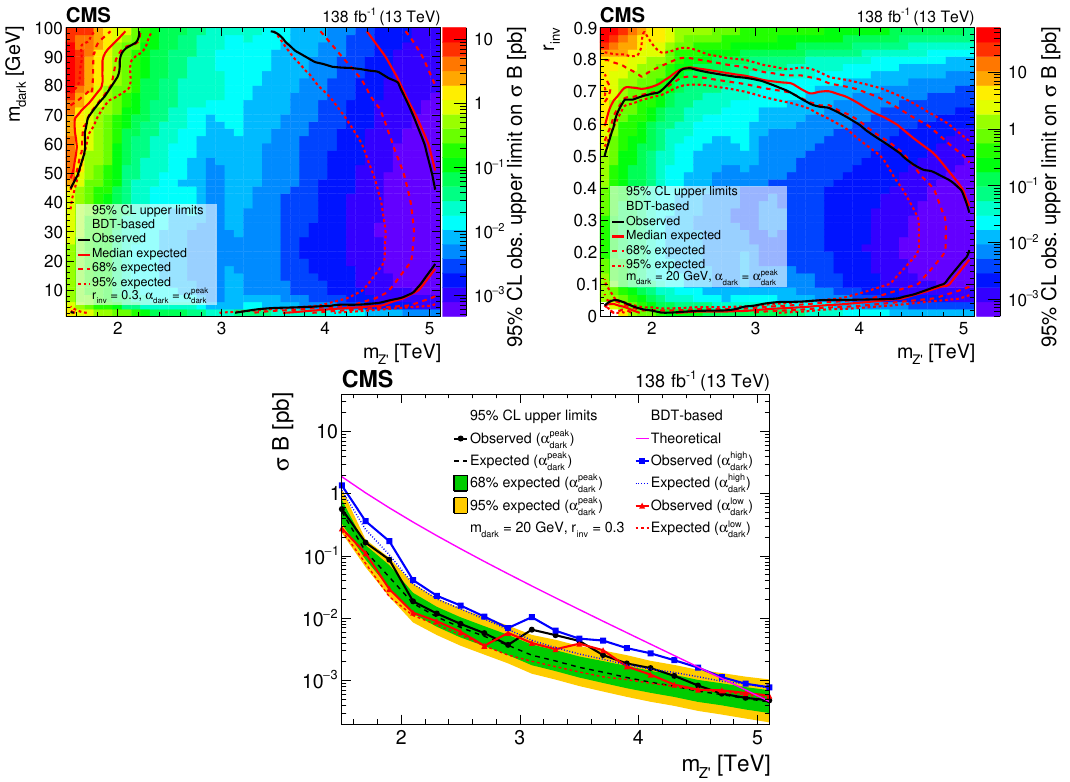
Figure 8 . The 95% CL upper limits on the product of the cross section and branching fraction from the BDT-based search, for variations of pairs of the signal model parameters. In the upper plots, the filled region indicates the observed upper limit. The solid black curves indicate the observed exclusions for the nominal Z 0 cross section, while the solid red curves indicate the expected exclusions, and the dashed lines indicate the regions containing 68 and 95% of the distributions of expected exclusions. The regions inside the circles are excluded. The lower plot shows the α multiple curves in one dimension, because there are only three parameter values considered. The black, blue, and red solid lines show the observed upper limits for each variation, while the dashed lines show the expected limits. The inner (green) and outer (yellow) bands indicate the regions containing 68 and 95%, respectively, of the distributions of expected limits. The purple solid line labeled “Theoretical” represents the nominal Z 0 cross